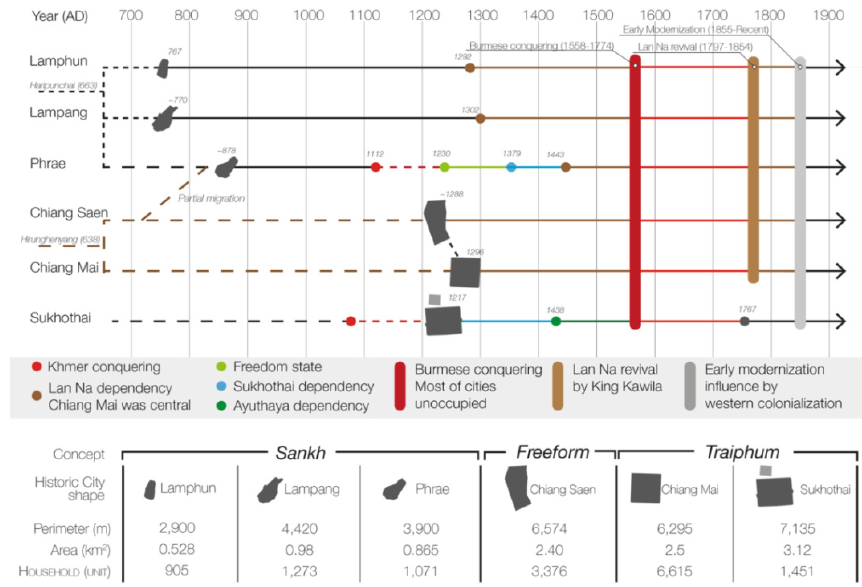
Figure 2. Chronology of the Lan Na cities (Srinurak and Mishima 2017, p. 5).